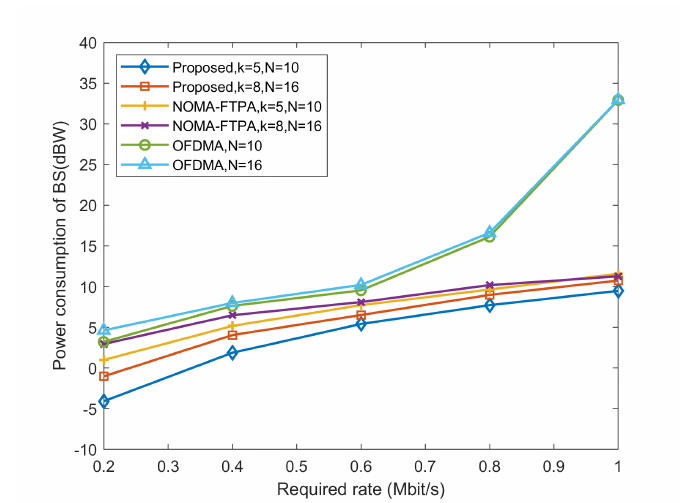
Figure 2. Power consumption of base station (BS) for different data rate requirements and different multi-carrier cases.